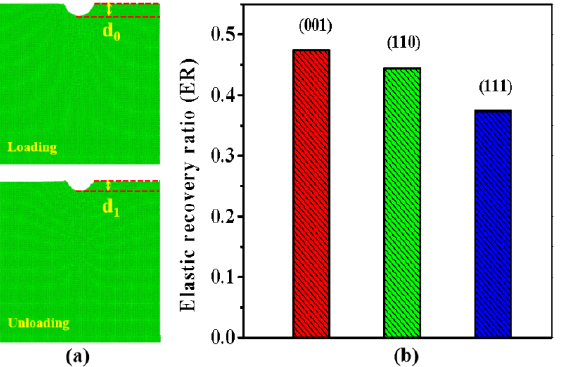
Figure 4. ( a ) Parameters for the definition of elastic recovery ratio after the retraction of indenter; ( b ) The elastic recovery ratio of the indented (001), (110) and (111) crystalline planes.